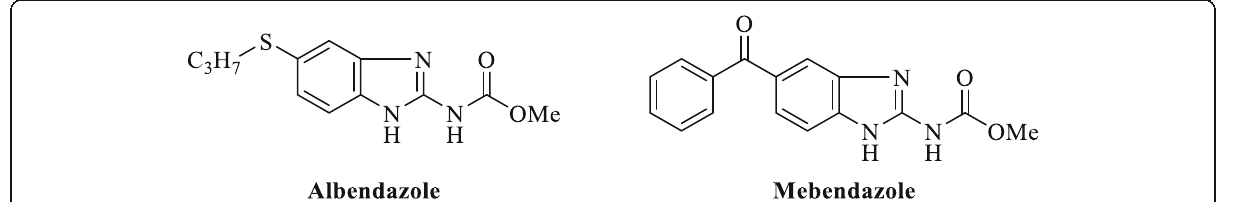
Fig. 1 Chemical structures of albendazole and